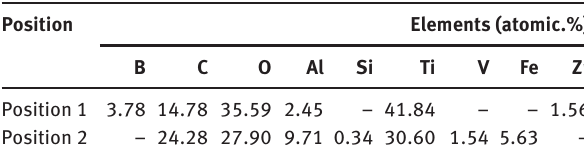
Figure 2: SEM image of the upper layer in the Fe tures and (B) points 1 and Table 1: EDS results of the different points in the Fe Al O laser clad composites. 2 3